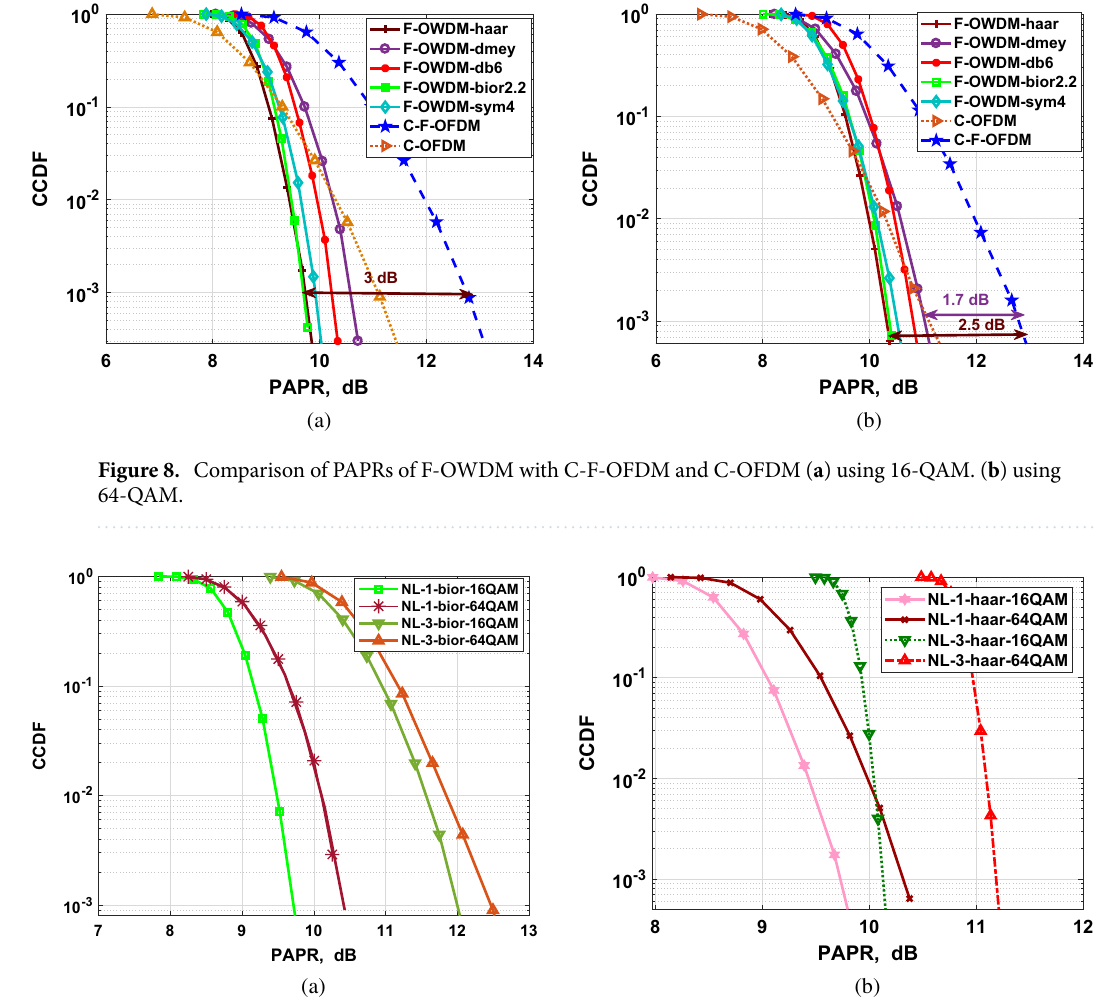
Figure 9. Comparison of PAPRs of F-OWDM using multilevel wavelet transform ( a ) bior 2.2-F-OWDM ( b ) haar